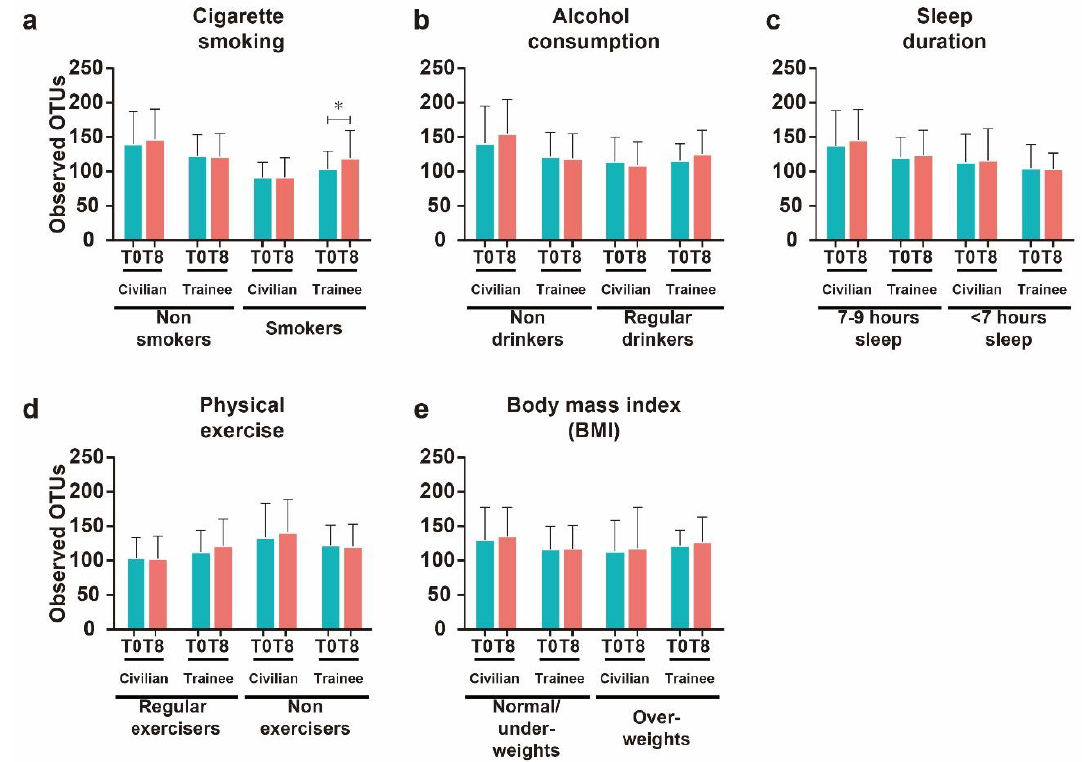
Figure 2. Number of observed OTUs detected at week zero (T0) and week eight (T8) in civilian and navy trainee groups. Number of OTUs at T0 and T8 in different categories: cigarette smoking ( a ), alcohol consumption ( b ), sleep duration ( c ), physical exercise ( d ), and body mass index (BMI) ( e ). Values are expressed as means ± SEM. Asterisk (*) indicates statistically significant ( p < 0.05) differences between groups based on Wilcoxon matched-pairs signed-rank test. At T8, the navy trainees had stopped smoking and drinking alcohol, and had been instructed to do physical exercise for 5 h per day and obey the 8 h sleep schedule.